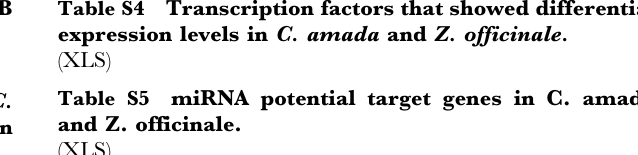
Table S4 Transcription factors that showed differential expression levels in C. amada and Z. officinale. Table S5 miRNA potential target genes in C. amada and Z.